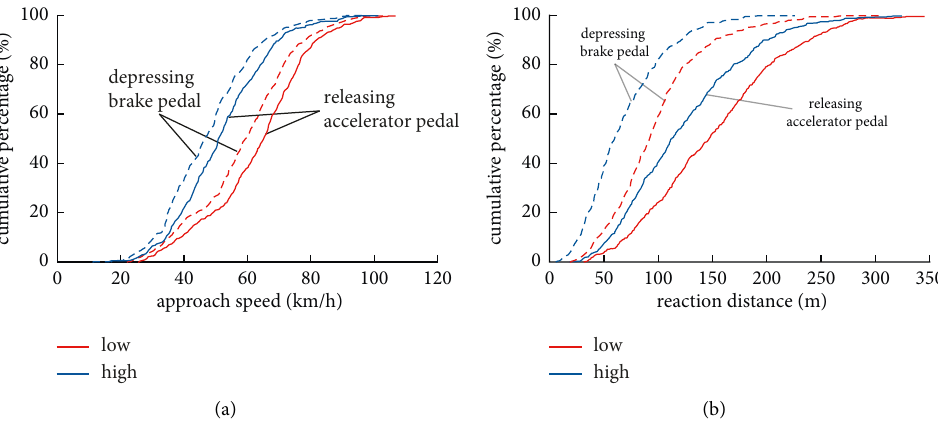
Figure 7: Approach speed and reaction distance by traffic density.